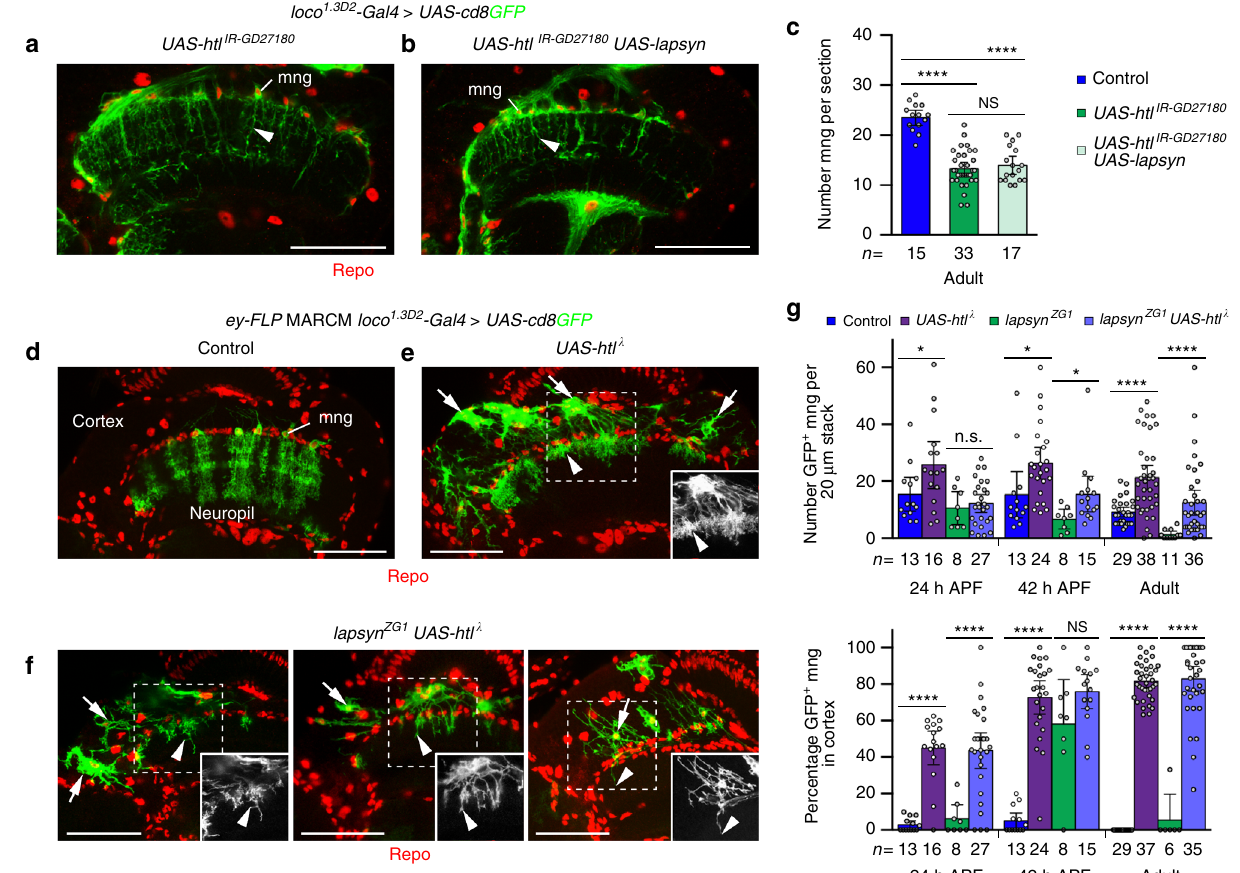
Fig. 8 lapsyn does not directly mediate survival of astrocyte-like mng. Repo-stained glial nuclei ( red ). a , b mng were labeled with loco 1.3D2 -Gal4 UAS-cd8GFP ( green ). htl knockdown with UAS-htl IR-GD27180 disrupted mng branch morphogenesis in adults ( a , arrowhead ). UAS-lapsyn expression did not rescue these defects ( b , arrowhead ). c Quanti fi cation of mng numbers. UAS-lapsyn expression did not rescue the decrease of cell numbers following htl knockdown. The scatter plot with bars shows data points and means ± 95% con fi dence intervals ( n = optic lobes (one optical section)). Unpaired, two-tailed Student ’ s t- test not assuming equal variance: P = 9.84 × 10 − 13 , P = 1.82 × 10 − 9 , P = 0.5166. d – f UAS-htl λ was expressed in mng clones using ey-FLP MARCM and loco 1.3D2 -Gal4 UAS-cd8GFP . Unlike in controls ( d ), wild-type clones ( e ), and lapsyn ZG1 mutant clones ( f ) expressing UAS-htl λ migrated into the medulla cortex and survived until adulthood ( arrows ). UAS-htl λ expressing clones extended short bushy processes into the neuropil ( e , arrowhead ). In lapsyn ZG1 mng clones expressing UAS-htl ( f ), branching is reduced in the cortex ( arrow ) and neuropil ( arrowheads ). g Quanti fi cation of ey-FLP MARCM clone numbers and localization at 24 and 42 h APF, and in adults. UAS-htl λ expression increased the number of glial cell clones compared to wild type and promoted lapsyn ZG1 clone survival. High percentages of wild type and lapsyn ZG1 clones overexpressing UAS-htl λ were found in the medulla cortex. Scatter plots with bars show data points and means ± 95% con fi dence intervals. Unpaired, two-tailed Student ’ s t- test not assuming equal variance: P = 0.0396, P = 0.5881, P = 0.0241, P = 0.0144, P = 2.49 × 10 − 6 , P = 1.04 × 10 − 5 ( top : n = 20- μ m stacks of optical sections from 4,7,2,9,6,10,3,6,14,16,4 and 14 optic lobes); P = 4.25 × 10 − 8 , P = 2.92 × 10 − 7 , P = 7.97 × 10 − 15 , P = 0.1432, P = 2.11 × 10 − 34 , P = 6.59 × 10 − 22 ( bottom : n = 20- μ m stacks from 4,7,2,9,6,10,3,6,14,15,4 and 14 optic lobes). NS , not signi fi cant, * P < 0.05, **** P < 0.0001. All image panels show projections. For genotypes, sample numbers and additional statistical values,